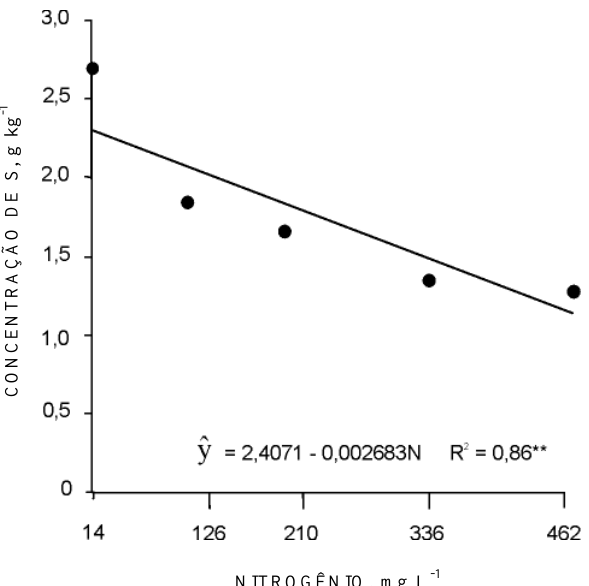
Figura 7. Concentração de enxofre nas raízes do capim-Marandu, considerando as doses de nitrogênio aos 79 dias do transplantio.